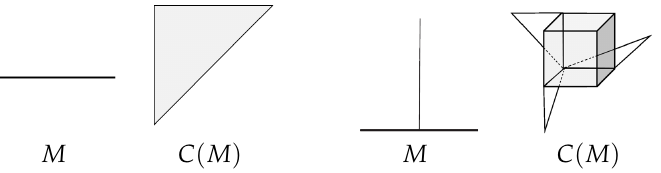
Figure 1. The hyperspaces C ( M ) for the path P 2 and the star S 3